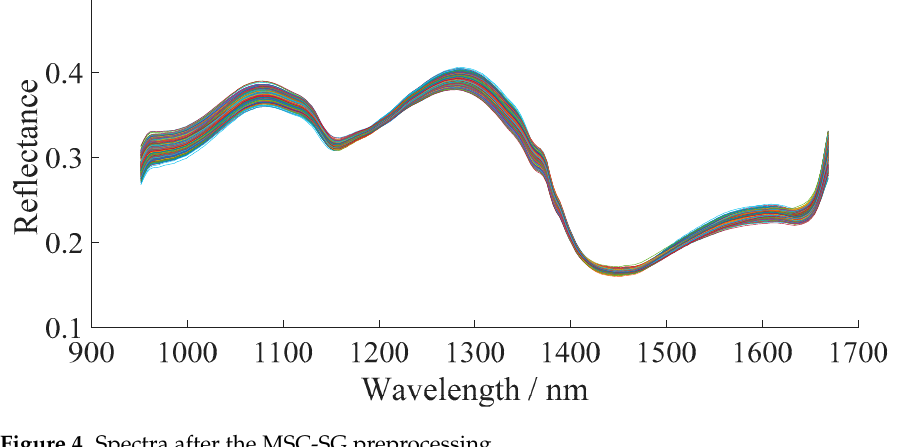
Figure 4. Spectra after the MSC-SG preprocessing.